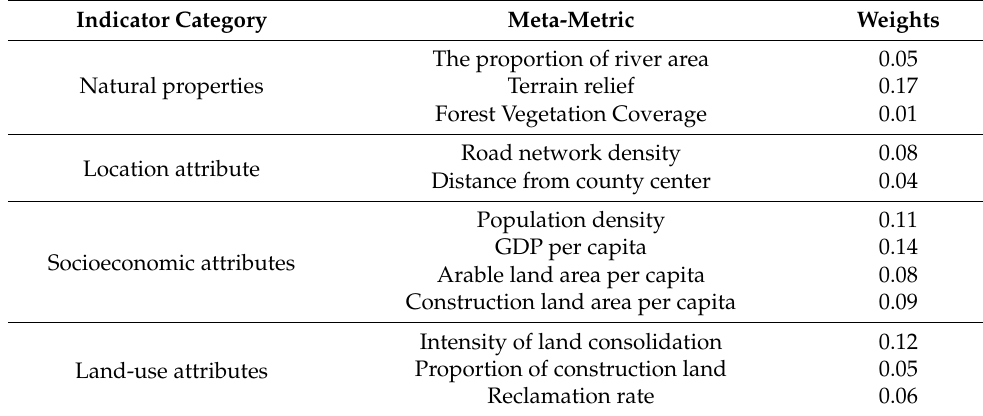
Table 2. Weights of 12 Meta